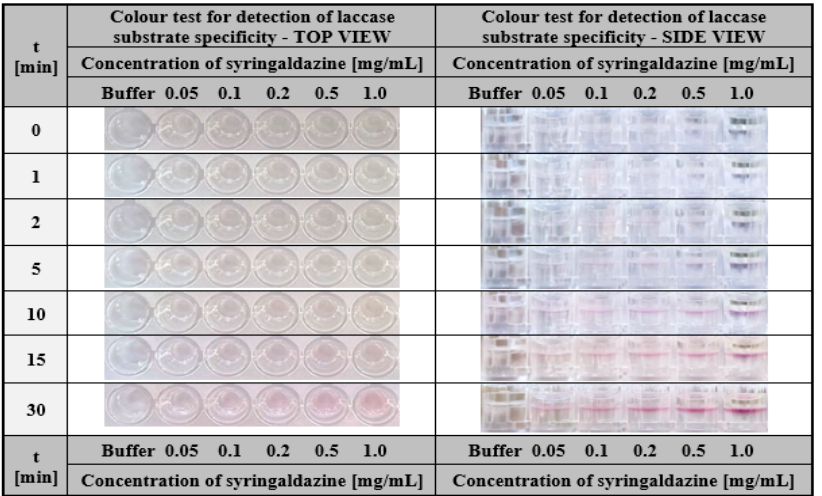
Figure 12. The visual response obtained after a different time of hydrogel-based test with immobi- lised laccase from T rametes versicolor (final concentration 200 µg/mL) performed for syringaldazine solutions with a concentration in the range of 0.05–1.0 mg/mL.